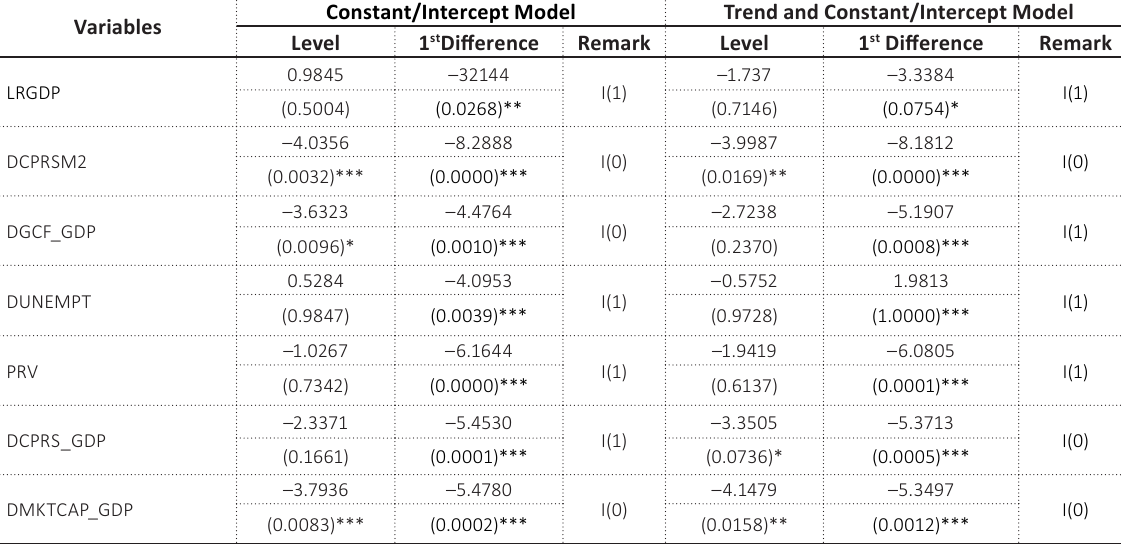
Table 2. Results of ADF unit root